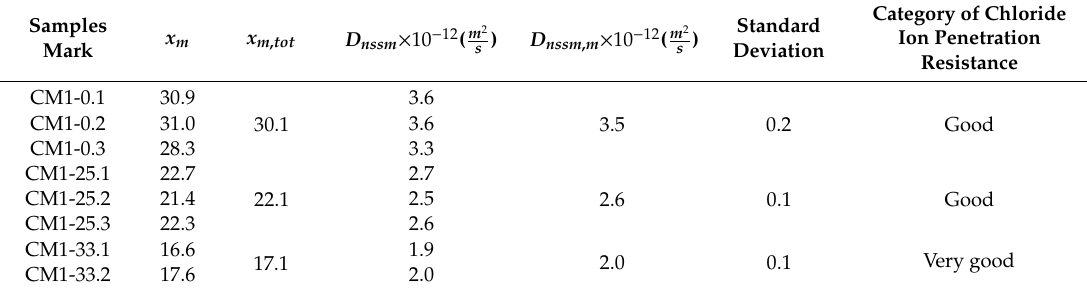
Table 6. Test results for determination of the chloride ion migration coe ffi